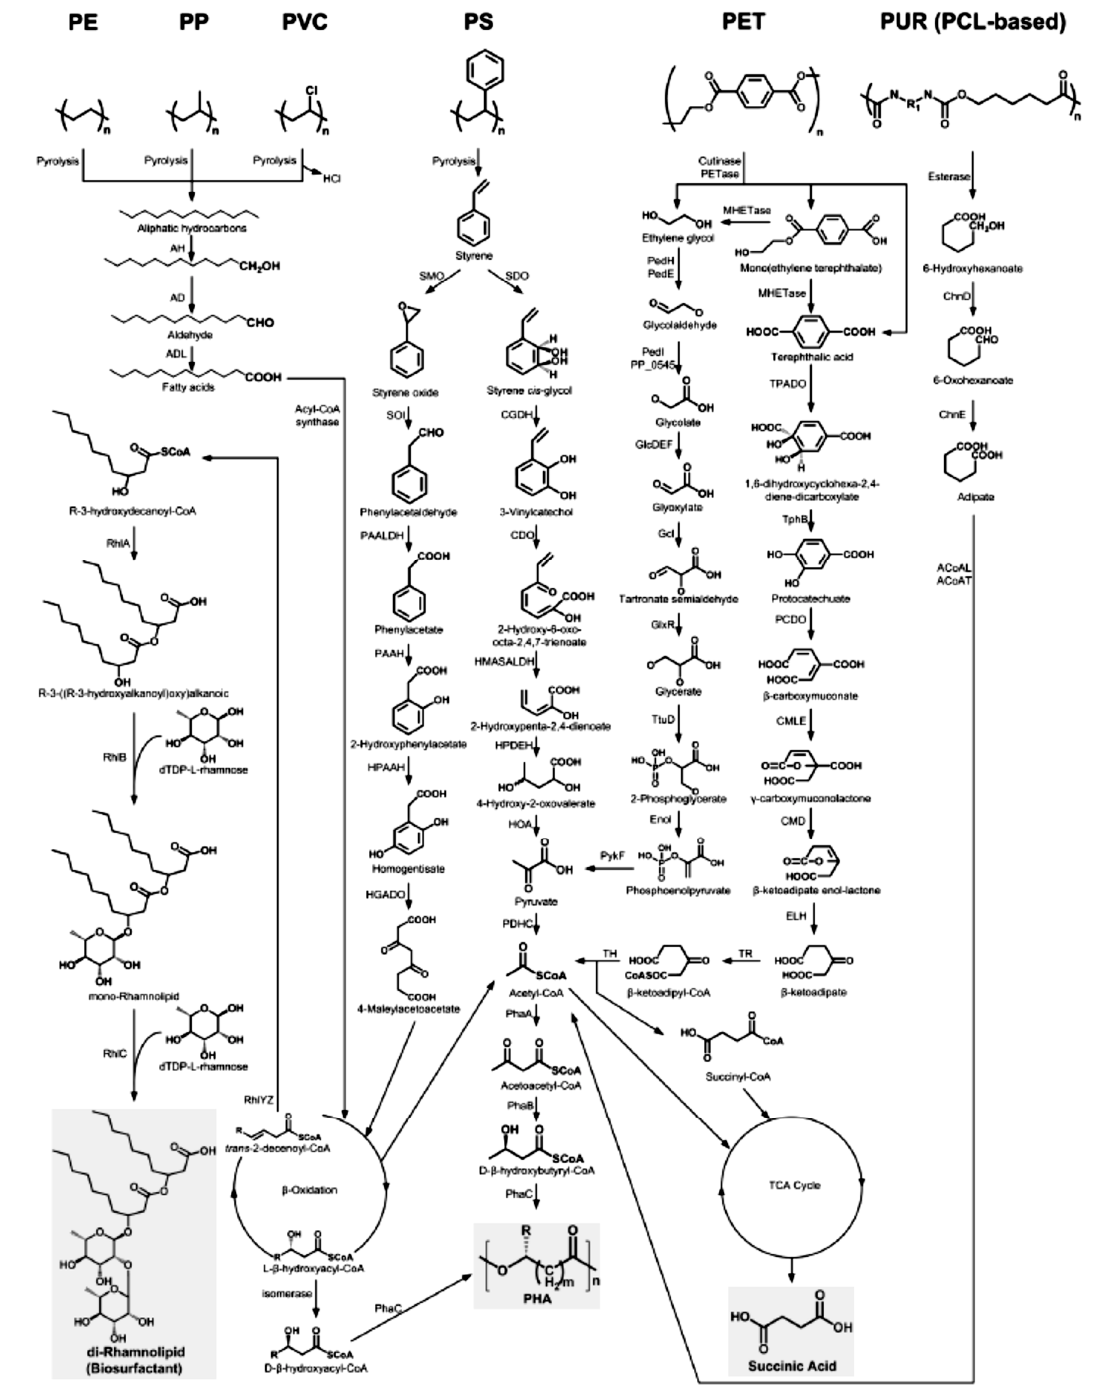
Figure 4. The metabolic pathways of depolymerization products of six kinds of plastics [74]. Plastics: PE, polyethylene; PS, polystyrene; PP, polypropylene; PVC, polyvinyl chloride; PUR, polyurethane; PCL, polycaprolactone diol; PET, polyethylene terephthalate. Enzymes: AH, alkane hydroxylase; AD, alcohol dehydrogenase; ALD, aldehyde dehydrogenase; RhlYZ, R-specific enoyl-CoA hydratase; RhlA, HAA synthetase; RhlB, rhamnosyltransferase 1; RhlC, rhamnosyltransferase 2; SMO, styrene monooxgenase; SOI styrene oxide isomerase; PAALDH, phenacetaldehyde dehydrogenase; PAAH, phenylacetate hydroxylase; HPAAH, 2-hydroxyphenylacetate hydroxylase; HGADO, homogentisate 1,2-dioxygenase; SDO, styrene dioxygenase; CGDH, cis-glycol dehydrogenase; CDO, catechol 2,3-dioxygenase; HMASALDH, 2-hydroxymuconic acid semialdehyde hydrolase; HPDEH, 2-hydroxypenta-2,4-dienoate hydratase; HOA, 4-hydroxy-2-oxovalerate aldolase; PDHC, pyruvate dehydrogenase complex; PhaA, b-ketothiolase; PhaB acetoacetyl-CoA reductase; PhaC, PHA synthase; PedH, quinoprotein alcohol dehydrogenase; PedE, quinoprotein alcohol dehydrogenase; PedI, aldehyde dehydrogenase family